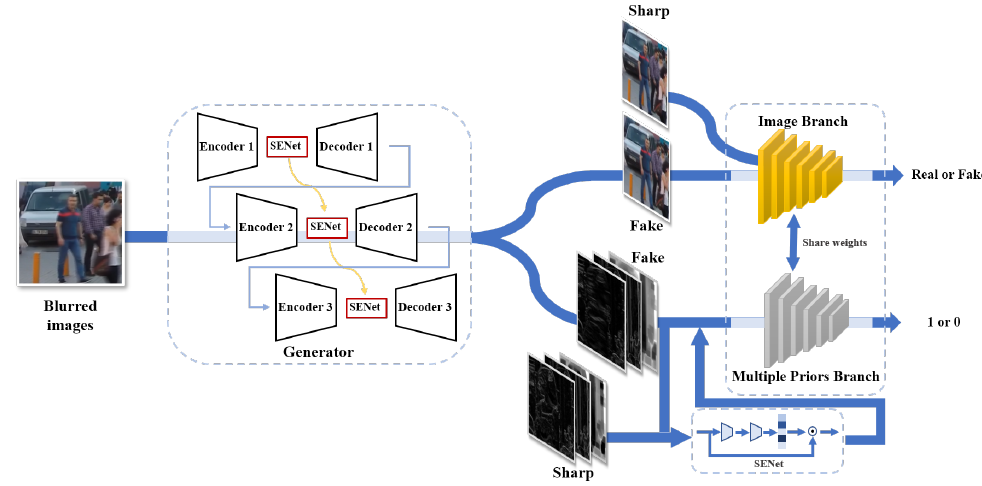
Figure 1. The illustration of our DBSGAN deblurring framework. The generator on the left is a multi-scale encode–decode module. The right part is our dual-branch discriminator which includes an image branch and a multiple-prior